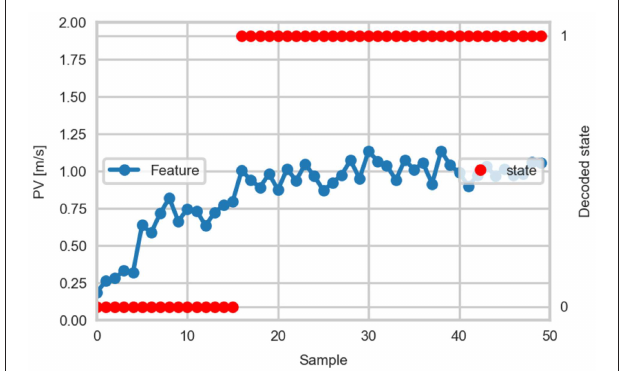
FIGURE 14 | Example of the decoded state from a 2-state HMM learned from peak velocity data. One sample corresponds to one trial. The decoded state labeled as 0 corresponds to the learning phase and the state labeled as 1 corresponds to the phase of stable